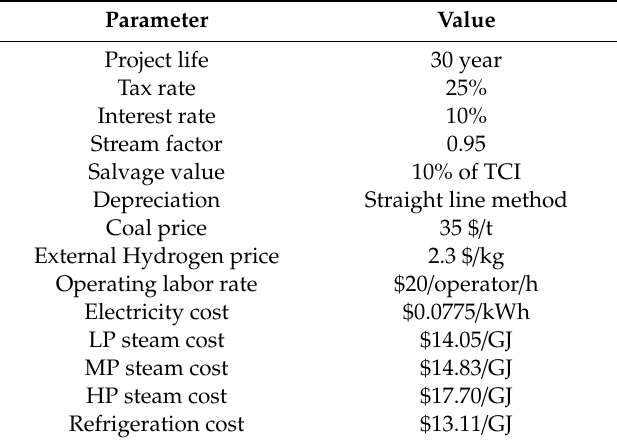
Table 4. Economic assumptions used in the analysis